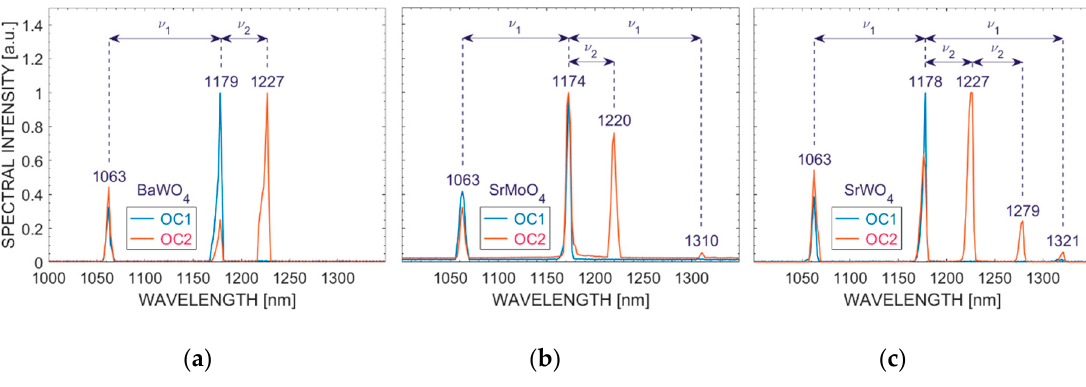
Figure 3. Output stimulated Raman scattering (SRS) radiation spectra for ( a ) BaWO 4 [82], ( b ) SrMoO 4 [88] and ( c ) SrWO 4 Raman lasers using two output couplers OC1 and OC2.